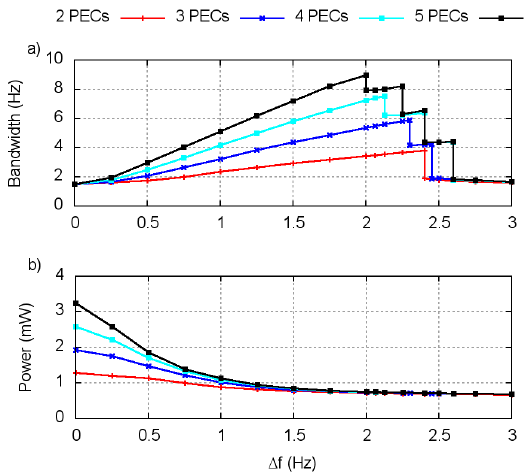
Figure 5. ( a ) Simulated dependence of the bandwidth on the frequency detuning Δ f ; ( b ) Dependence of the power at the half-power frequencies on the frequency detuning Δ f .